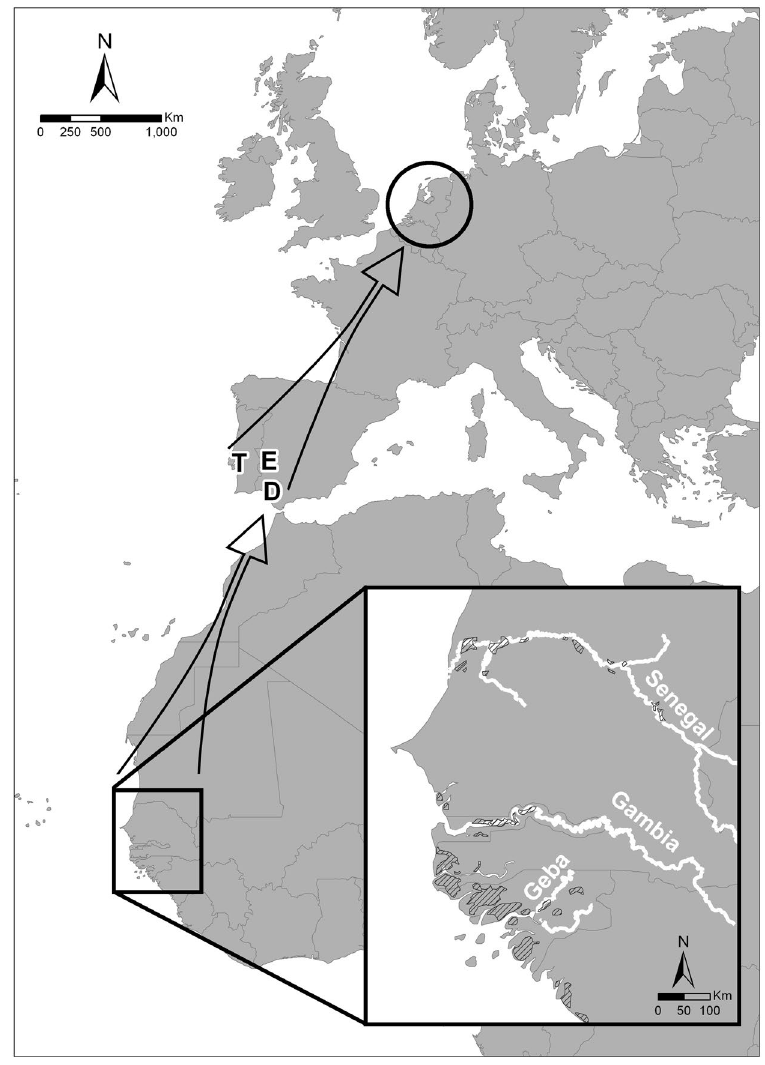
Figure 4. Map showing the location of main breeding (Western Europe) and wintering (West Africa) grounds of continental black-tailed godwits Limosa limosa limosa . During northward migration, most individuals fly non-stop from wetlands in West Africa to their major staging sites in southern Europe (D: Doñana, T: Tagus estuary, E: Extremadura rice fields). Arrows show direction of major migration routes, and lined areas show the main rice fields used by godwits during the non-breeding season in West Africa 20 . Map was created with ArcGIS version 10.1